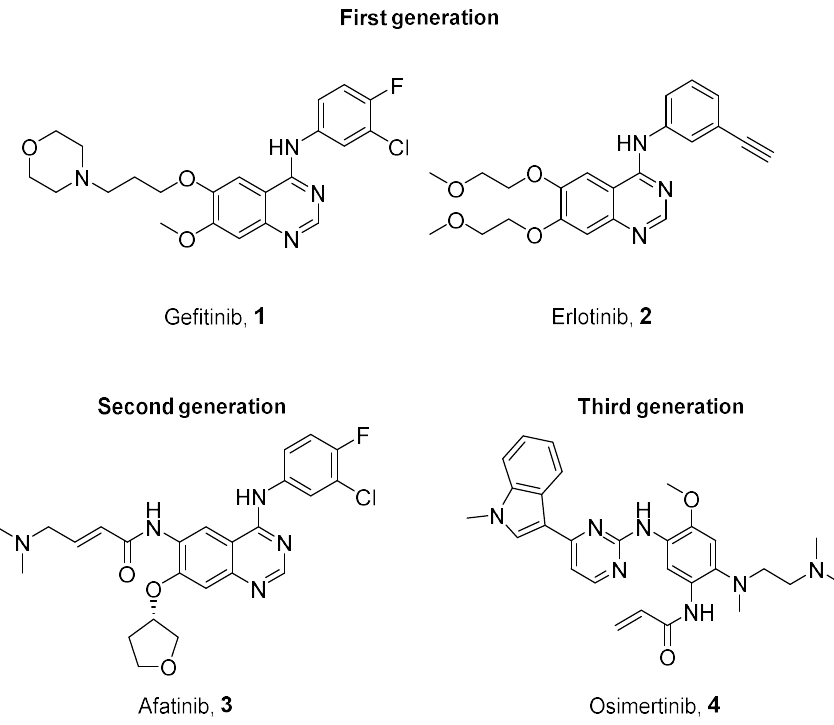
Figure 1. Examples of first, second and third generations epidermal growth factor receptor tyrosine kinase inhibitors.